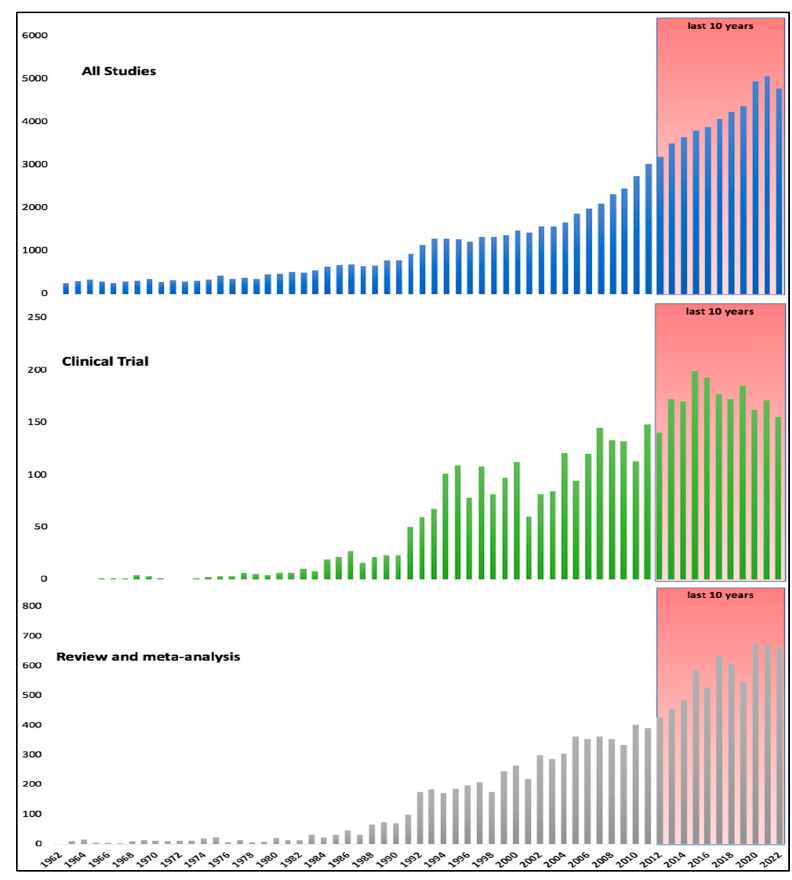
Figure 1. Studies on cardiac arrest published in the last 60 years, with a focus on the last ten years.